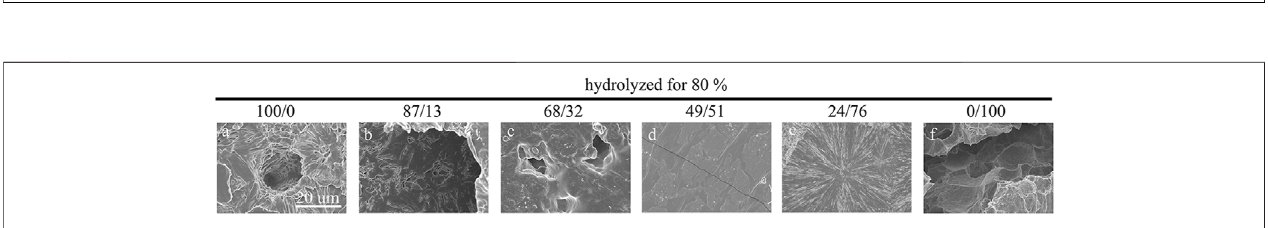
FIGURE 7 | SEM images of the polyester fi lms after 80% of their masses were enzymatically hydrolyzed. (A – F) : PHS, P(HS- co -13ES), P(HS- co -32ES), P(HS- co - 51ES), P(HS- co -76ES), and PES).